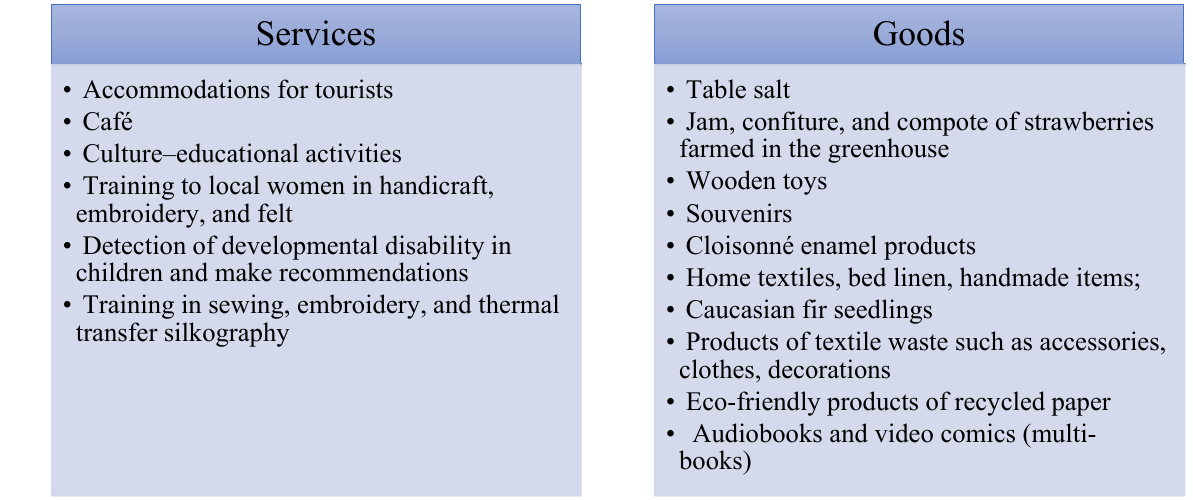
Figure 6. Nature of Interviewed Social Enterprises. Source: own data.